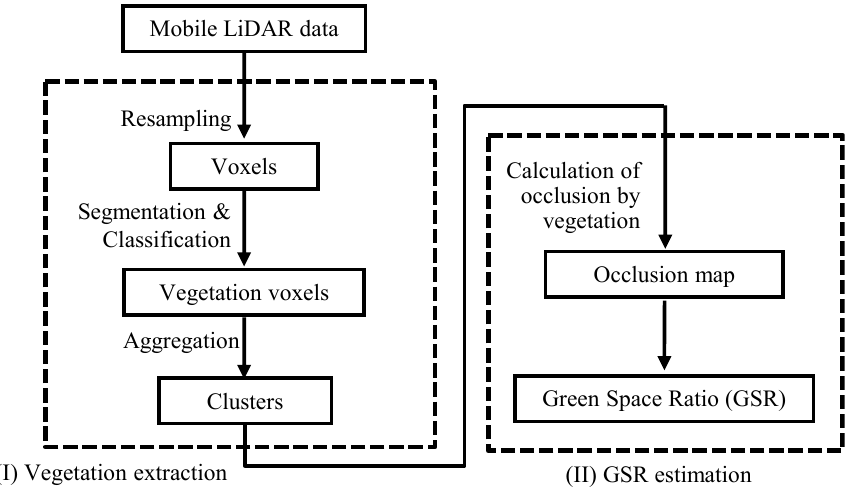
Figure 4. Flowchart of the proposed method for estimating GSR from mobile scanning data.